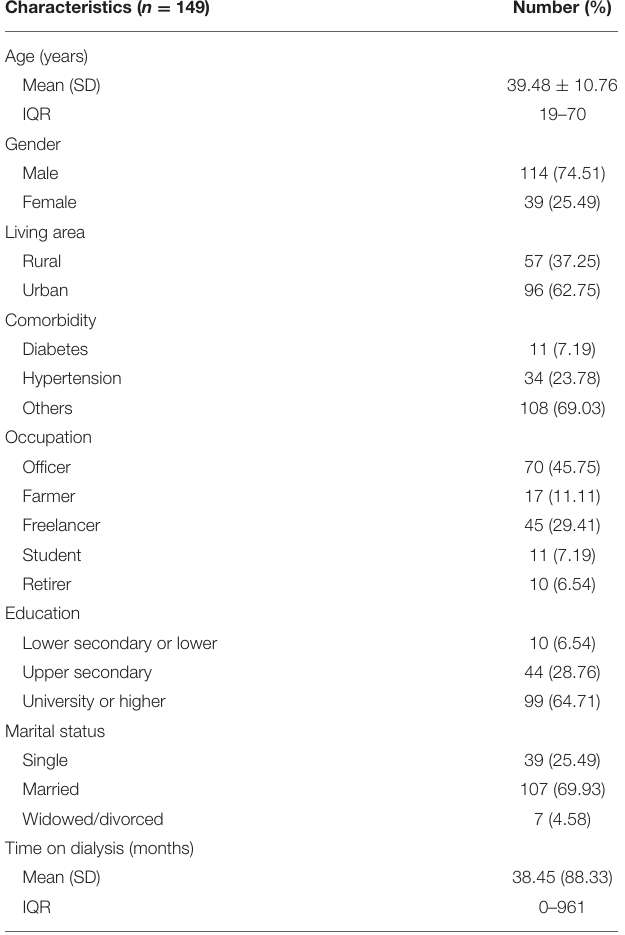
TABLE 1 | Patient characteristics.